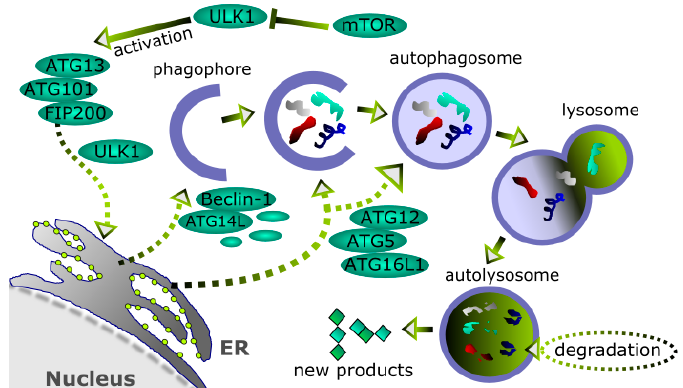
Figure 4. Autophagy. Unnecessary or damaged cellular material, including organelles, trapped in a nucleating endoplasmic reticulum (ER)-related membrane (phagophore) to form a closed vehicle (autophagosome) is delivered to lysosome, which fusions with autophagosome, giving autolysosme, in which the material is finally degraded and recycled. Basically, autophagy can proceed as an mTOR (mammalian target of rapamycin)-dependent, as presented in this figure, or -independent mechanism. Many proteins are involved in autophagy, including autophagy-related (ATG) proteins, Beclin-1, which suppresses ULK1 (Unc-51-like autophagy activating kinase 1) complex, and LC3 (microtubule-associated protein 1A/1B-light chain 3). Sharp arrows—activation, blunt arrows—inhibition, dashed short arrows—possible, not always occurring routes.